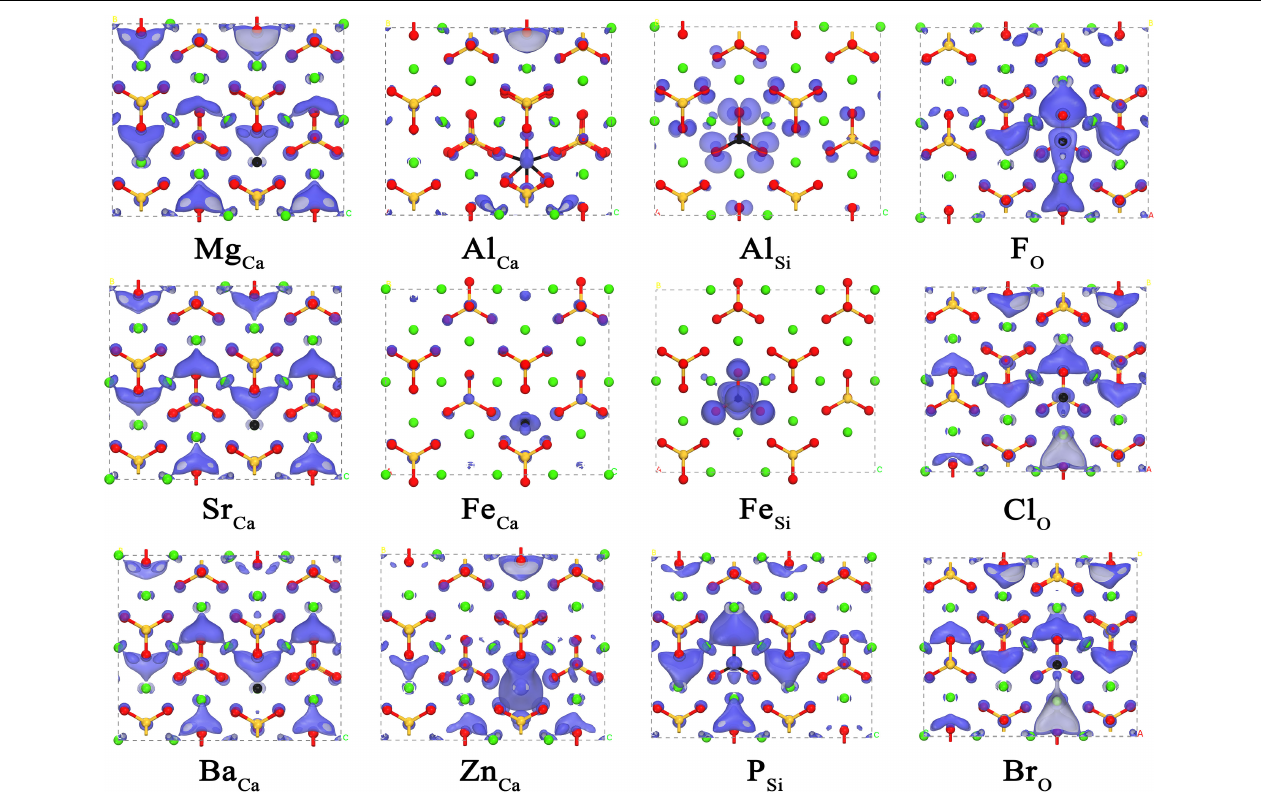
FIGURE 5 | The local charge density distribution of the conduction band minimum of doped γ -Ca 2 SiO 4 crystals. The green, orange, red, and black spheres are Ca, Si, O, and dopant atoms, respectively.